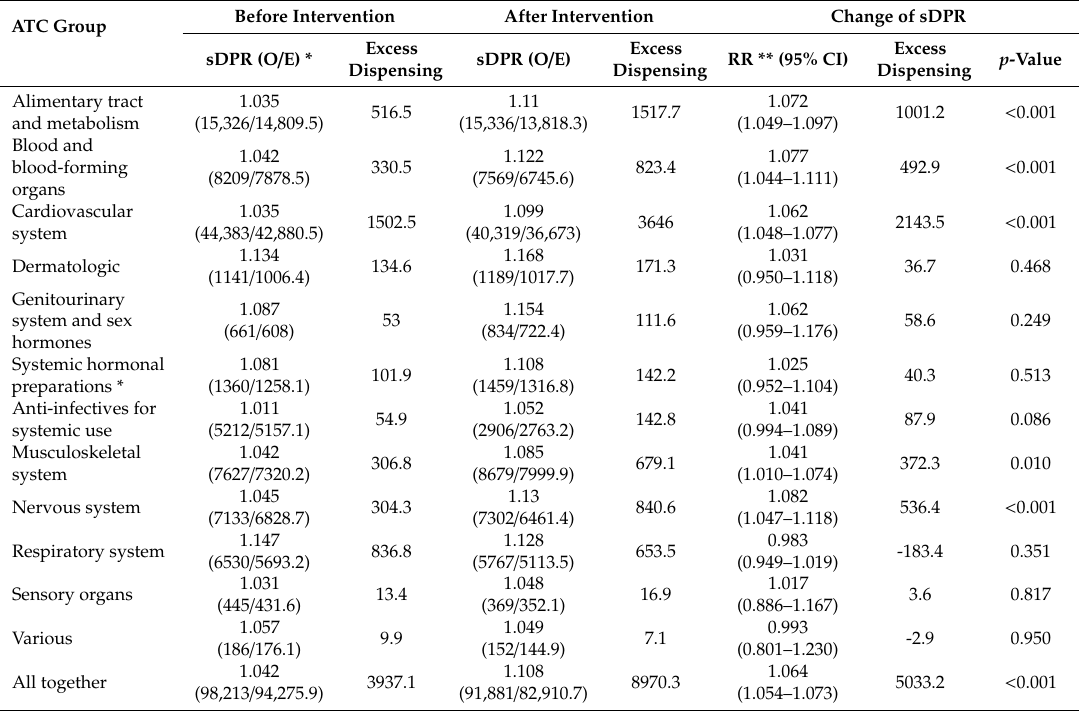
Table 4. Changes in standardized dispensed-to-prescribed ratio (sDPR) in the intervention area and the number of excess dispensed prescriptions attributable to the program’s implementation (stratified by ATC drug